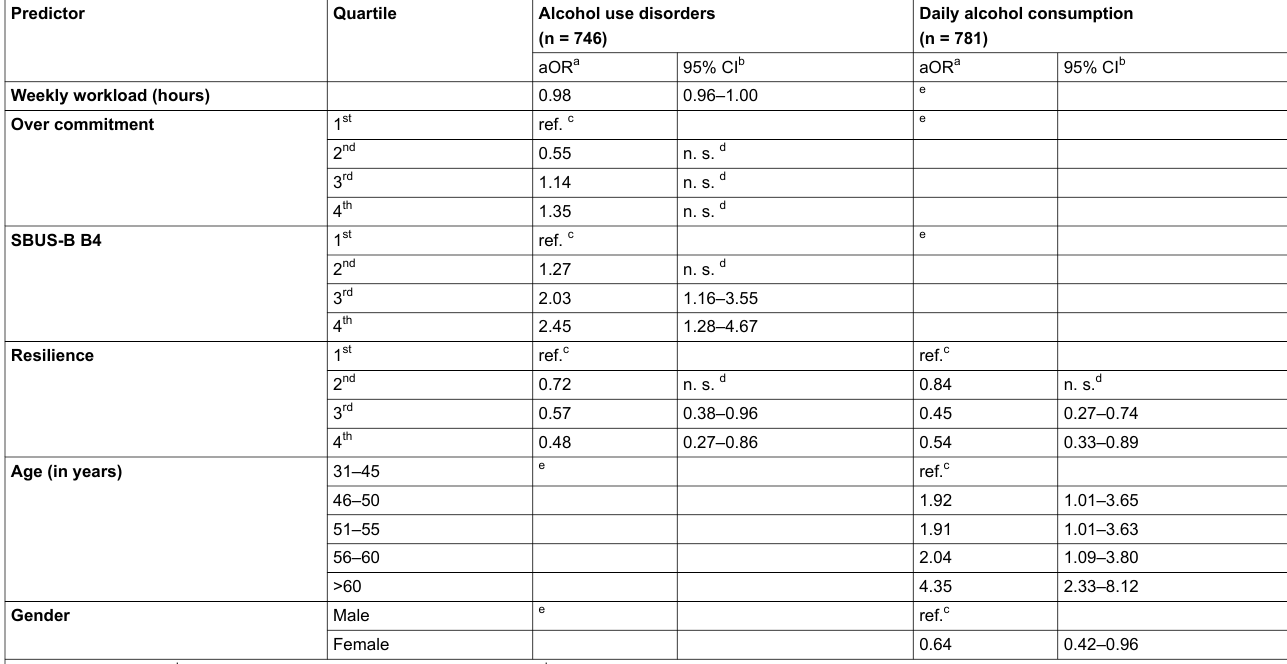
Table 4: Final set of predictors and adjusted odds ratios of the binary logistic regression models to predict alcohol use disorders and daily alcohol consumption (inclusion